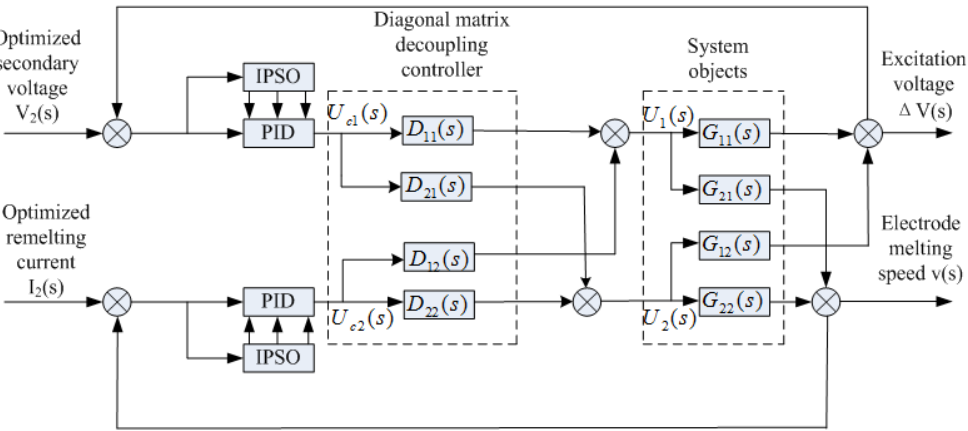
Figure 3. Configuration of self-tuning PID decoupling control